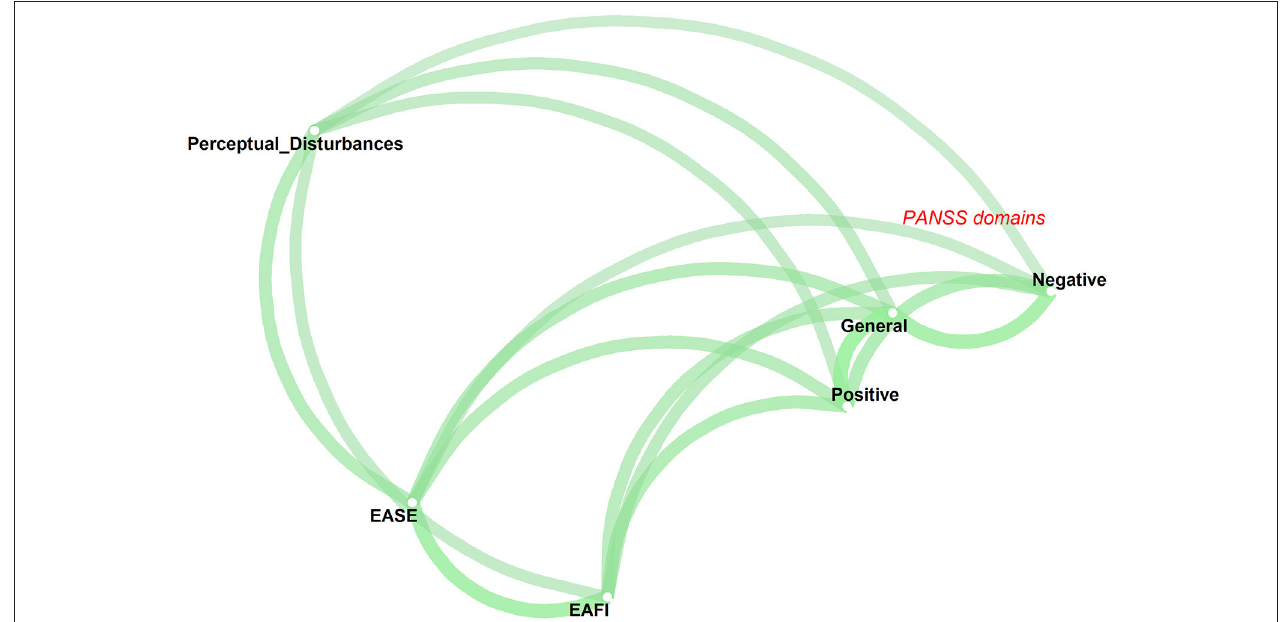
FIGURE 1 | Psychopathological network showing the pairwise associations among anomalies of imagination (EAFI), self-disorders (EASE), perceptual disturbance and positive, negative and general symptoms (PANSS dimensions). The thickness of the lines connecting the variables is proportional to their correlations with the target